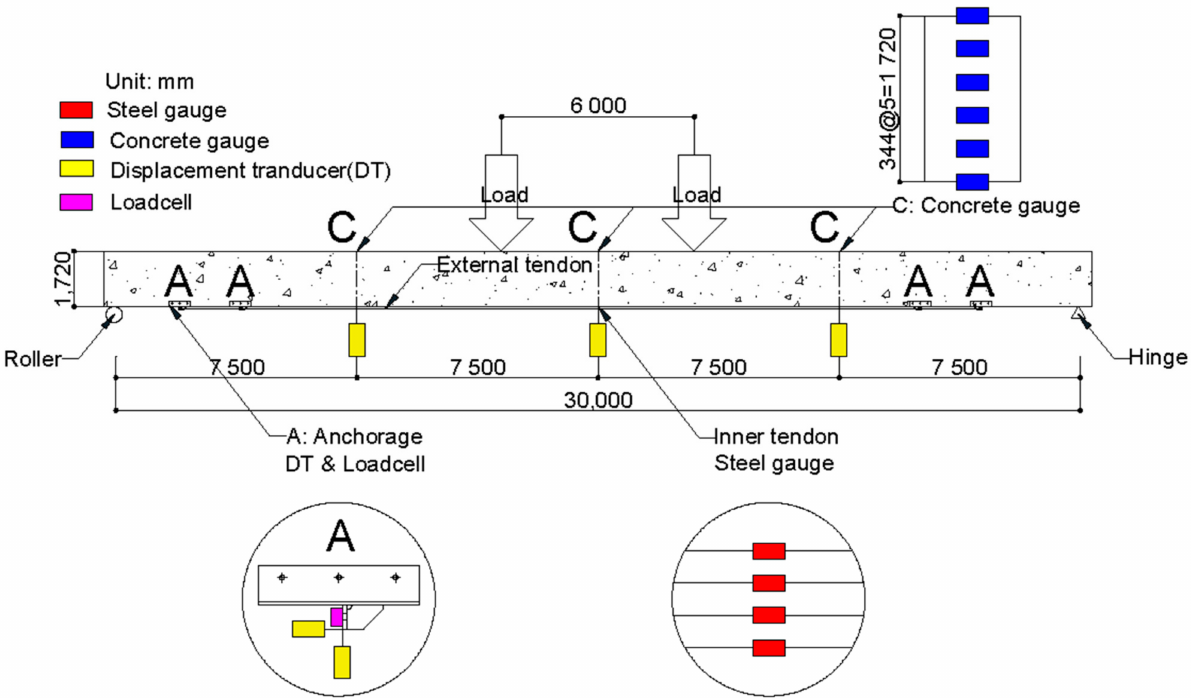
Figure 5. Experimental setting.